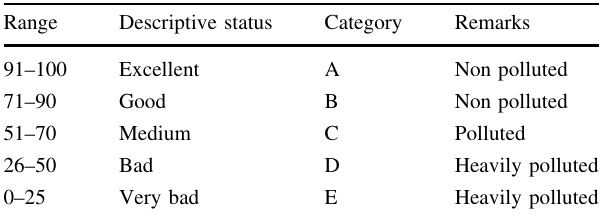
Table 3 Classification criteria standards based on NSF-WQI (after Tyagi et al. 2013)